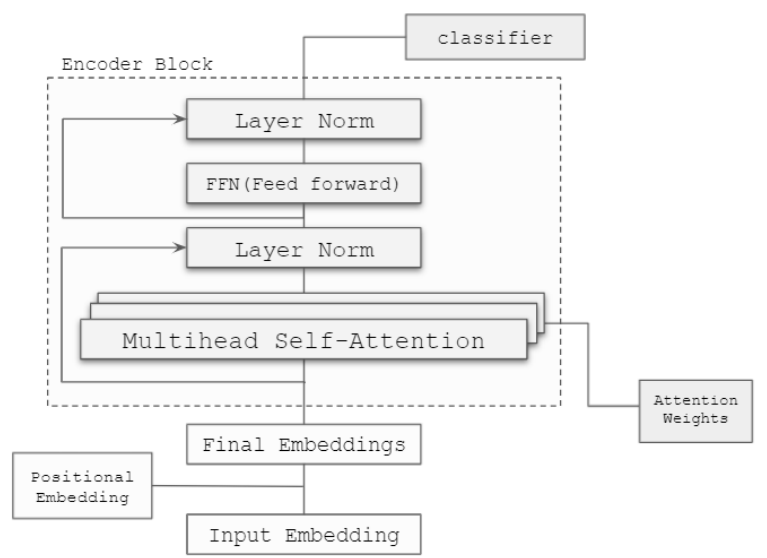
Figure 3. Self-Attention